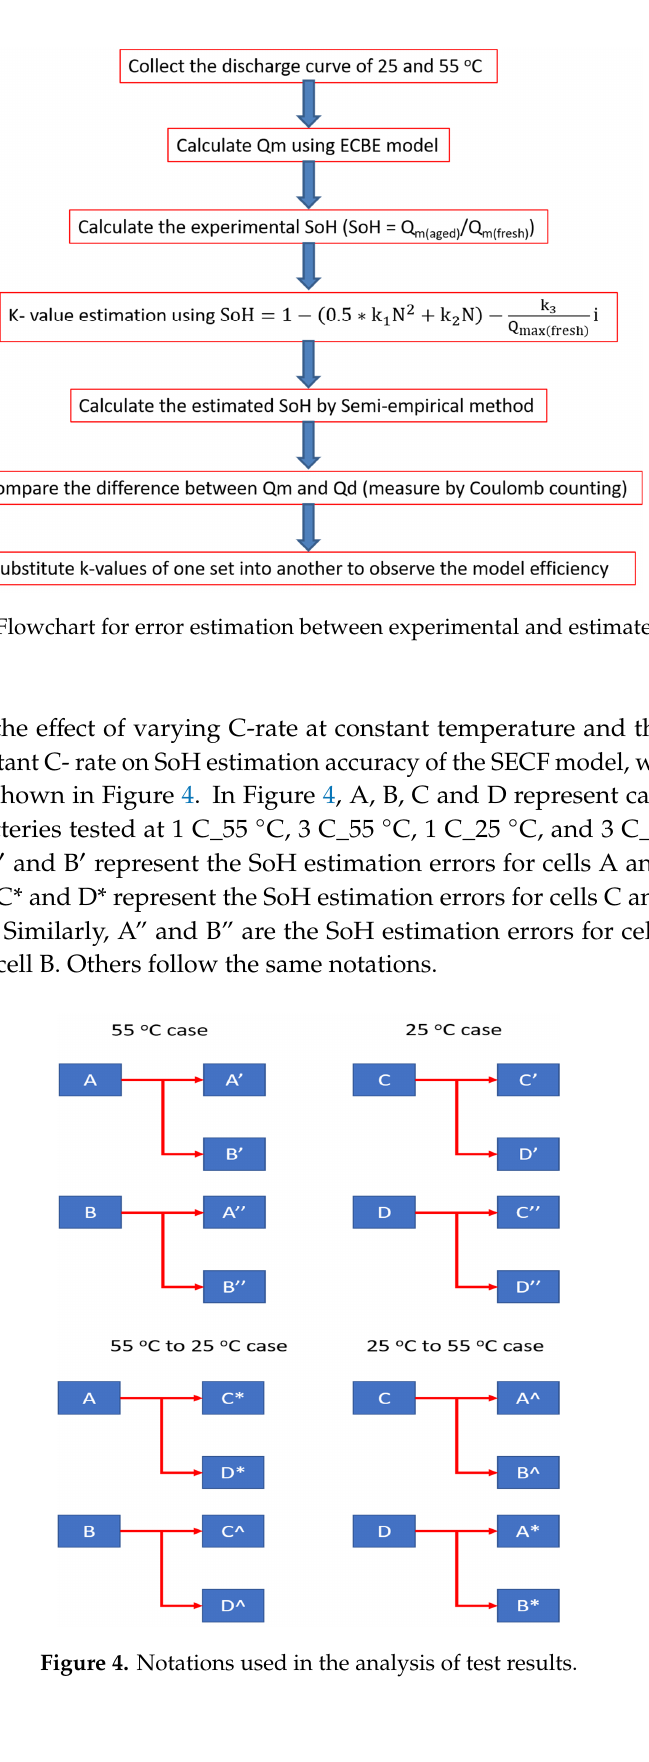
Table 4. Experimental SoH at 55 °C based on the Qm computed from the ECBE model. Cycle Number